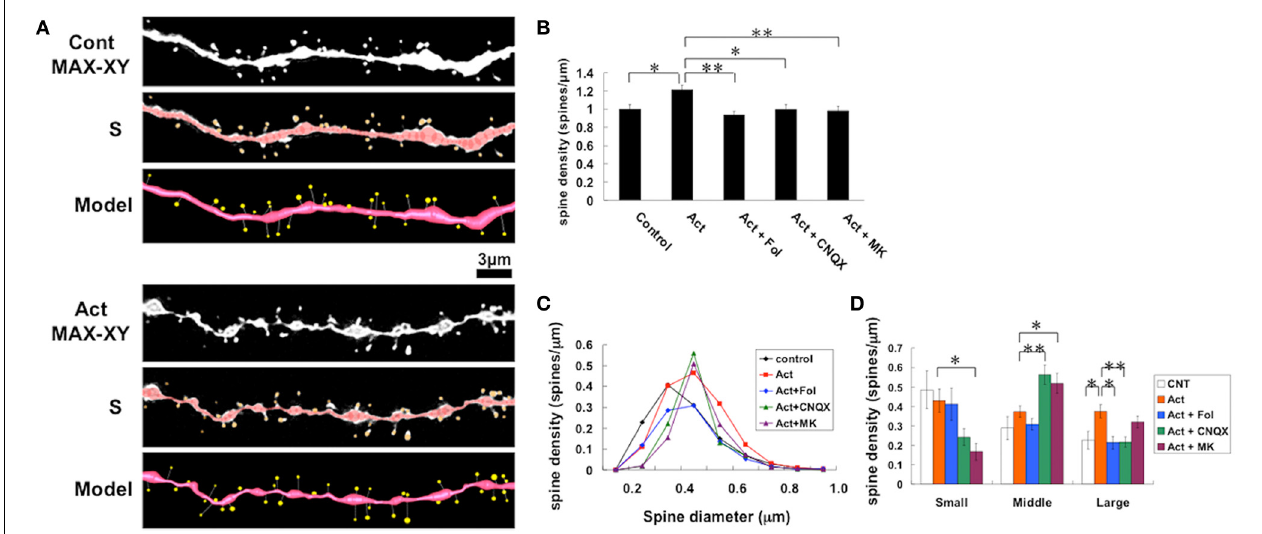
FIGURE 3 | Changes in the density and morphology of spines by activin and drugs in hippocampal slices. Spines were analyzed along the secondary dendrites of pyramidal neurons in the stratum radiatum of CA1 neurons. (A) Representative images of confocal micrographs; spines along dendrite without drug-treatments (Cont) and spines along dendrite after activin treatment for 2h (Act). Maximal intensity projection onto XY plane from z-series confocal micrographs (MAX-XY), image analyzed by Spiso-3D (S) and 3 dimensional model (Model) are shown together. Bar, 3 μ m. (B) Effect of treatments by activin and glutamate receptor blockers on the total spine density in CA1 neurons. Vertical axis is the average number of spines per 1 μ m. A 2-h treatment in ACSF without drugs (Control, total spine numbers = 552, 8 neurons), with 10ng/mL activin A (Act), with 10ng/mL activin and 100ng/mL follistatin (Act + Fol), with 10ng/mL activin and 20 μ M CNQX (Act + CNQX, total spine numbers = 977, 11 neurons, P = 0 . 005), with 10ng/mL activin and 50 μ M MK-801 (Act + MK). Statistical significance is calculated against activin treated group and indicated by stars. ∗ P < 0 . 05, ∗∗ P < 0 . 01.